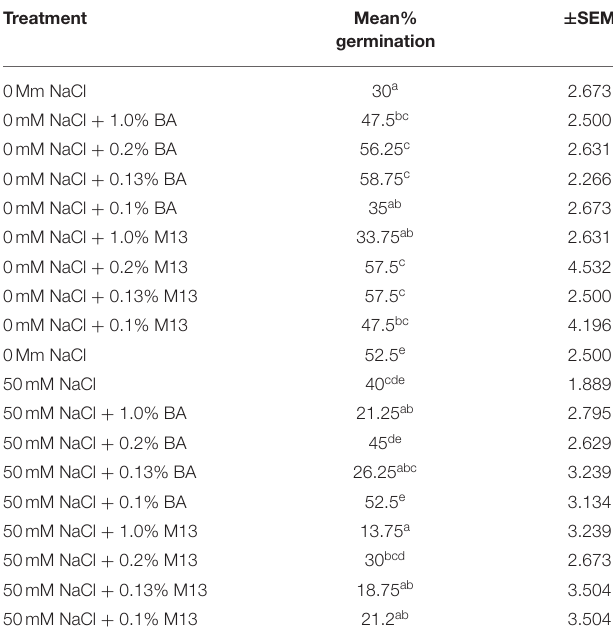
TABLE 8 | Effect of treatment on mean percentage germination of corn exposed to 0 and 50mM NaCl, for 24h.